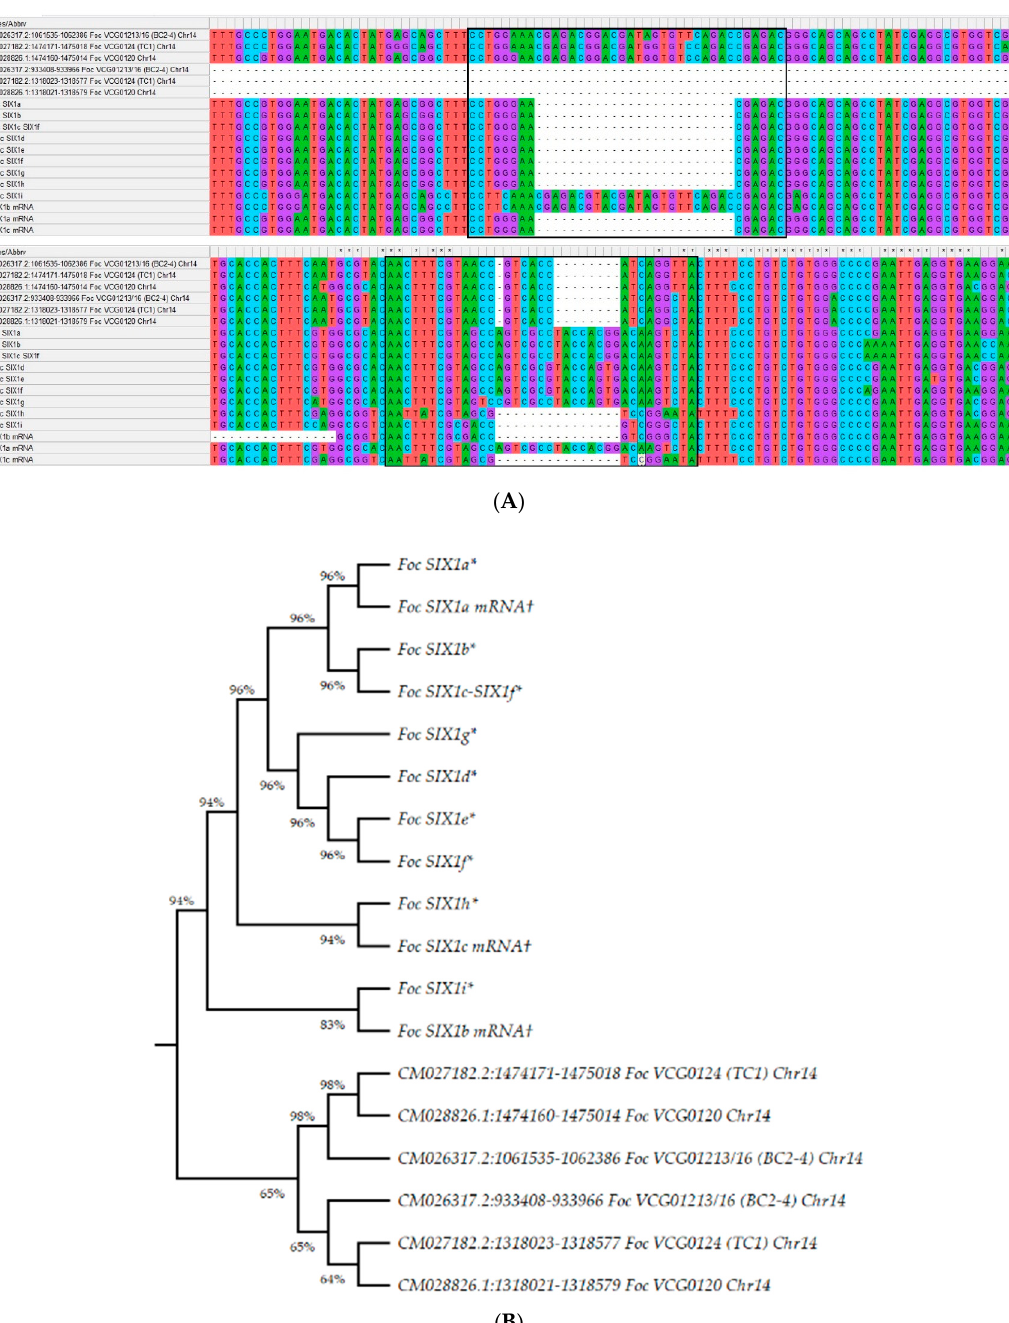
Figure 5. Comparison of SIX1a-i genes of Foc VCGs infecting the Cavendish banana with the sequences of Czislowski et al. and Guo et al. ( A ); phylogenetic analysis based on SIX1a-i using MegaX 10.2.5 with the maximum-likelihood method ( B ). Numbers represent bootstrap values from 1000 replicates. The SIX1a-i sequences obtained from Czislowski et al. [44] and Guo et al. [19] are denoted as * and †, respectively, and the sequences of Indian VCGs were obtained from assembled genomes of Foc R1 VGC0124 (TC1): GCA_011316005.3; Foc STR4 VCG0120: GCA_016802205.1; and Foc TR4 VGC01213/16 (BC2-4): GCA_014282265.3.